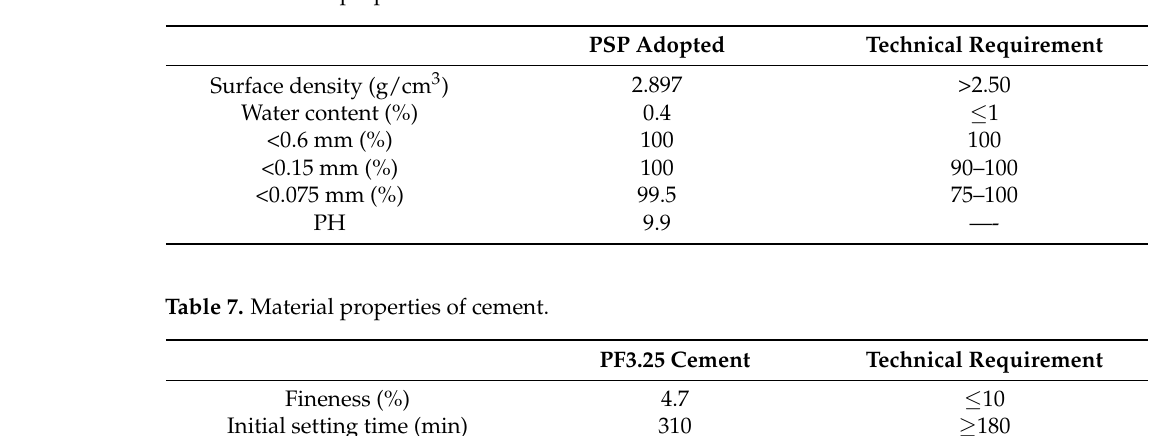
Table 6. Material properties of PSP.